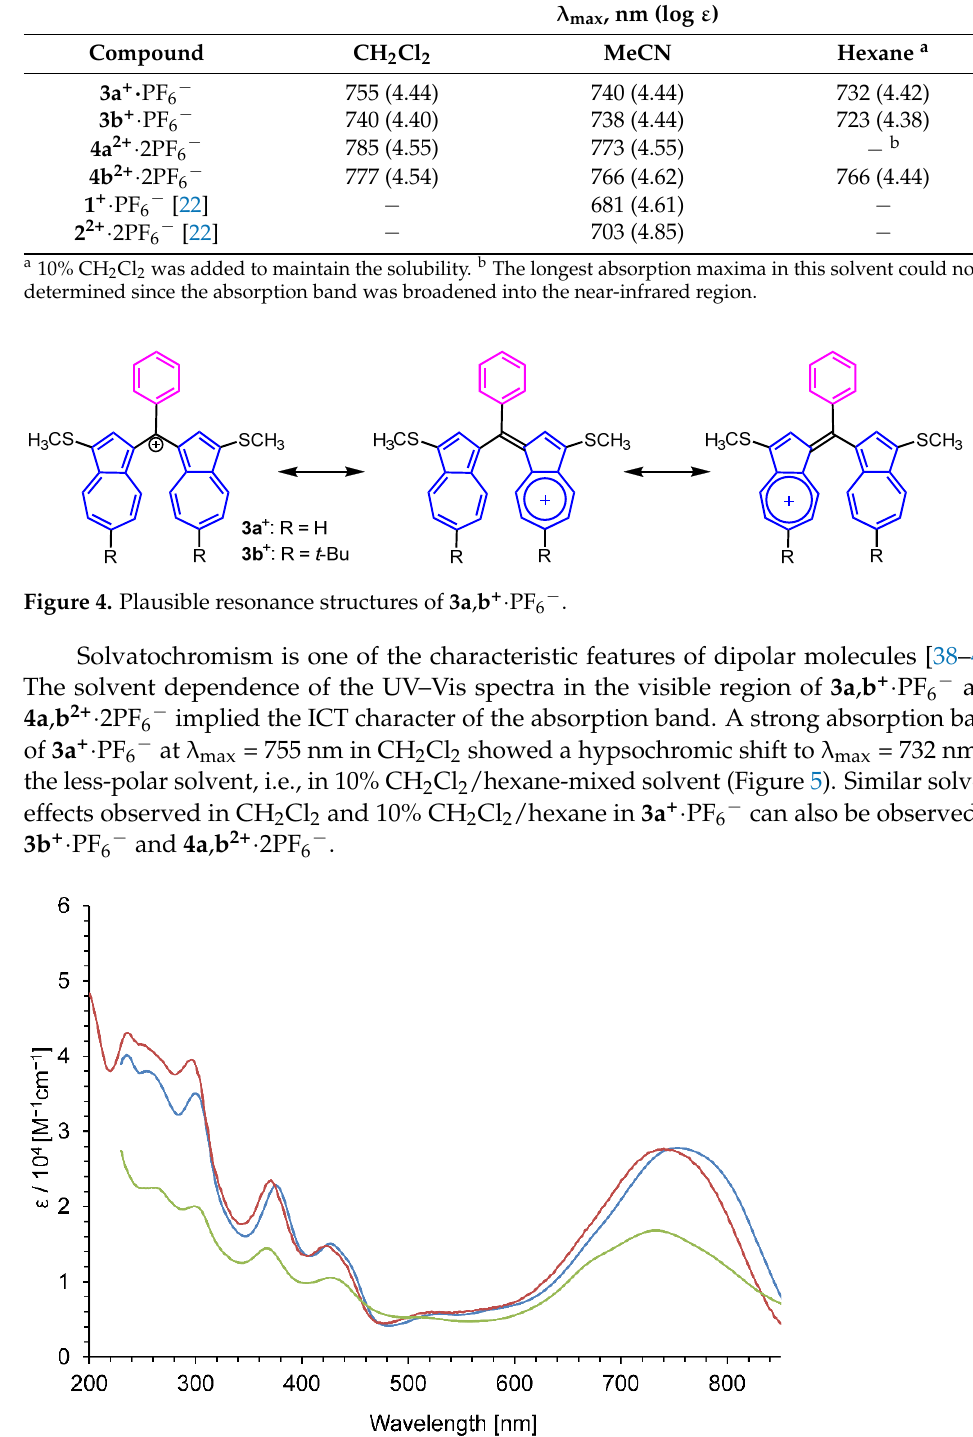
Table 1. The longest absorption maxima [nm] and their coefficients (log ε ) of 3a , b + ·PF 6 − and 4a , b 2+ ·2PF 6 − in several solvents, and those of 1 + ·PF 6 − and 2 2+ ·2PF 6 − in acetonitrile (MeCN) as a reference.